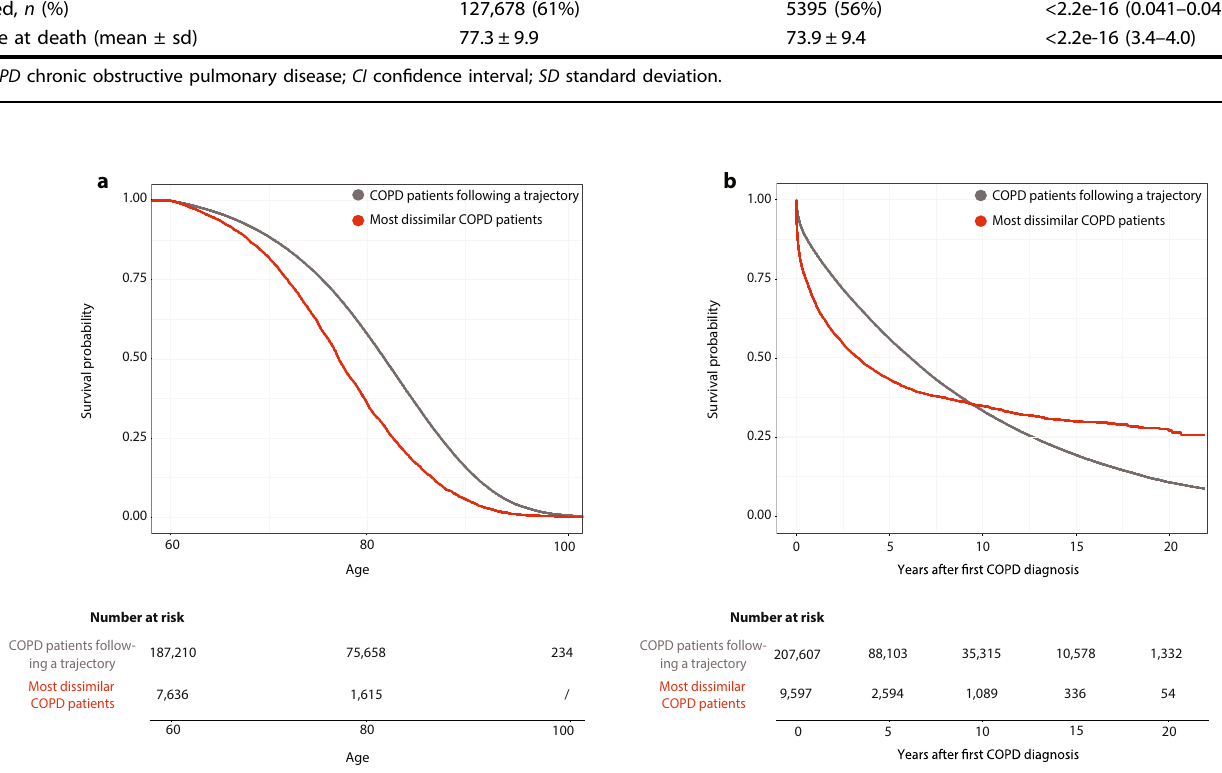
Fig. 4 Survival curves for the survival of patients that follow a trajectory and the most dissimilar patients. Kaplan – Meier survival curves showing the survival of chronic obstructive pulmonary disease (COPD) patients that follow at least one trajectory and the most dissimilar patients. a The overall survival of the two groups of patients, show that the most dissimilar patients tend to die earlier than COPD patients that follow a trajectory. b Survival after the COPD diagnosis shows that most dissimilar patients have a different shape on the survival curve. Some patients die very fast after COPD diagnosis, whereas others live long after the